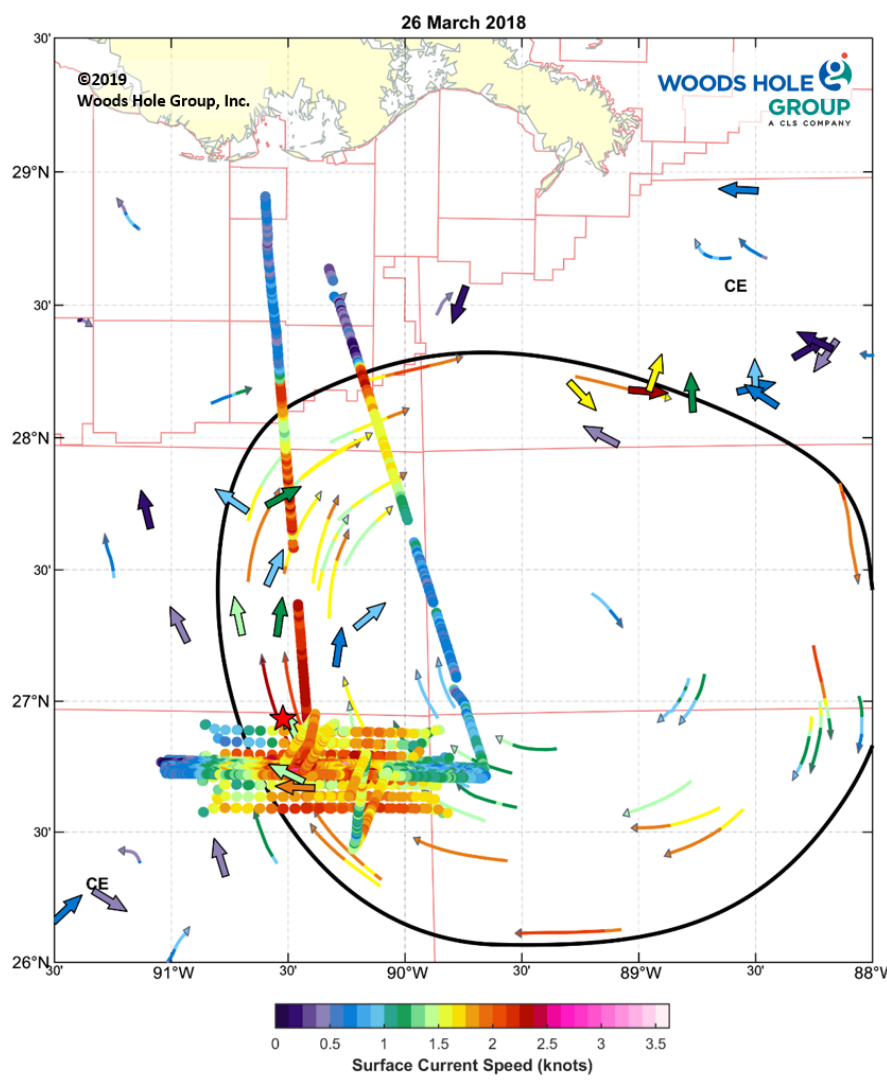
Figure 2. Eddy Quantum current front on 2018-03-26 as a black line inferred from models. The thin arrows show glider paths traveled during collection and speeds showing the current at depth. The thicker arrows show in situ currents at various platform locations. The ROCIS data (colored circles) is followed from and to the Bay of Barataria to the swaths collected such that they overlap the DopplerScatt swaths. The DopplerScatt data (also colored circles) are shown heavily undersampled as it covers an area of approximately ∼ 30km by ∼ 100km. Current speed in knots is represented by color shown in the colorbar. The star denotes the general location of the two in situ platforms. Their exact location is given in the Results